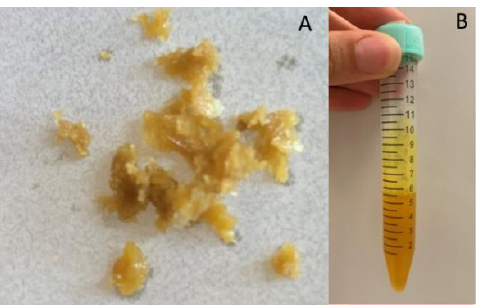
Figure 2. Pictures of dry extract (D.E.) ( A ) and liquid extract (L.E.) ( B ).